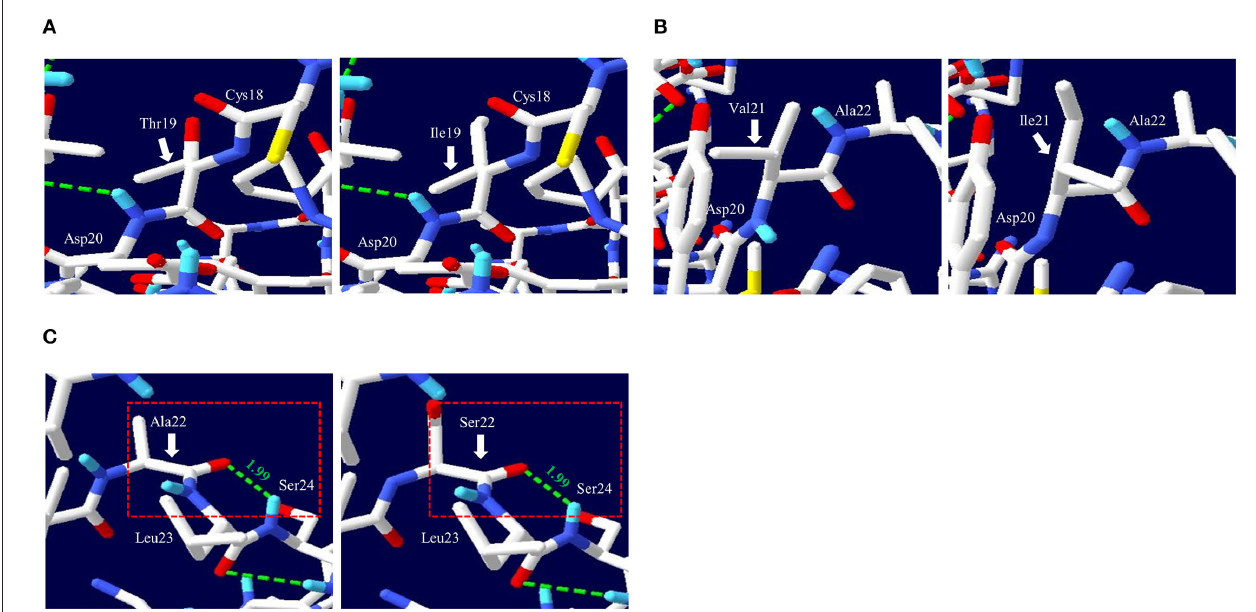
FIGURE 2 | Prediction of tertiary structure and hydrogen bonds of quail prion protein (PrP). (A) Comparison of the 3D structure and hydrogen bond of quail PrP according to the T19I alleles. The left panel indicates the 3D structure of quail PrP with allele T19. The right panel indicates the 3D structure of quail PrP with allele I19. (B) Comparison of the 3D structure and hydrogen bond of quail PrP according to the V21I alleles. The left panel indicates the 3D structure of quail PrP with allele V21. The right panel indicates the 3D structure of quail PrP with allele I21. (C) Comparison of the 3D structure and hydrogen bond of quail PrP according to the A22S alleles. The left panel indicates the 3D structure of quail PrP with allele A22. The right panel indicates the 3D structure of quail PrP with allele S22. The green dotted lines indicate hydrogen bonds. The green numbers indicate the distance of the hydrogen bonds.